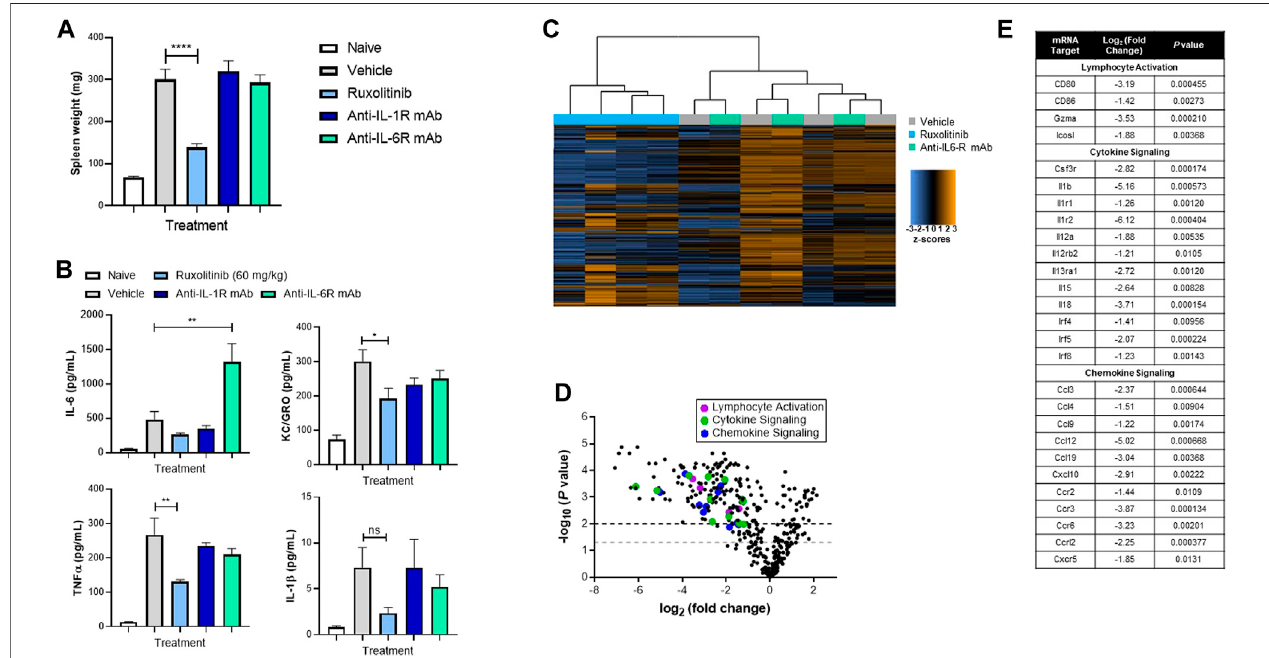
FIGURE2| Ruxolitinibabrogates hyperin fl ammation inamurinemodelofsecondary HLH.C57BL/6animalswereinjectedwith50 μ gofCpGDNAondays0,2,4, 6, and 8. Starting on day 5, corresponding mice were treated with vehicle, ruxolitinib, anti-IL-1R mAb, or anti-IL-6R mAb. On day 9, animals were sacri fi ced, and spleen size (A) andcytokines (B) weremeasured.Dataarerepresentativeof fi veindependentexperiments.* p < 0.05,*** p < 0.001,**** p < 0.0001 (C) HeatmapofsplenicT-cell mRNA expression pro fi ling panel, with blue indicating downregulation and orange indicating upregulation. Genes below threshold count ( < 20) were removed (D) Volcano plot of splenic T-cell differential gene expression between ruxolitinib and vehicle (baseline) treatment. Points above the gray and black dashed lines indicate adjusted p < 0.05 and < 0.01, respectively (E) Table highlighting individual differentially expressed proin fl ammatory genes.